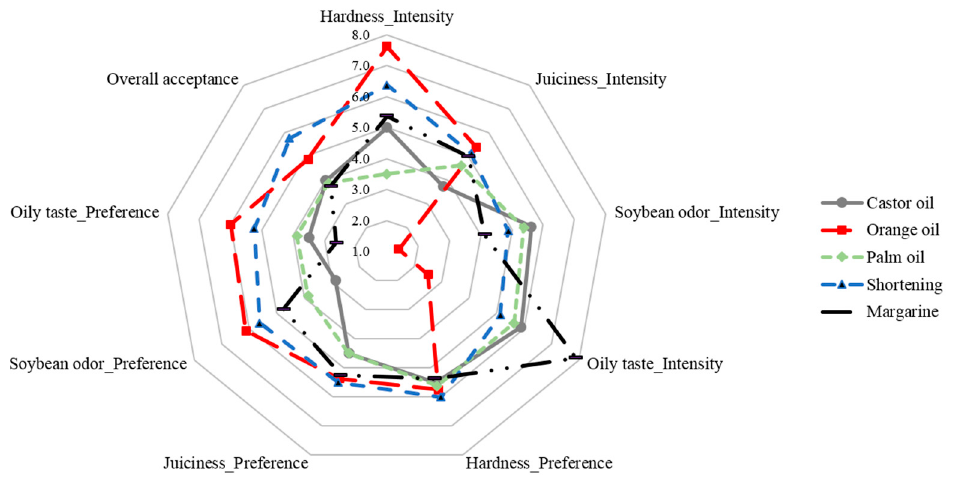
Figure 1. Sensory evaluation of meat analog supplemented with castor oil ( ● ), orange oil ( ■ ), palm oil ( ◆ ), shortening ( ▲ ), and margarine ( ― ).